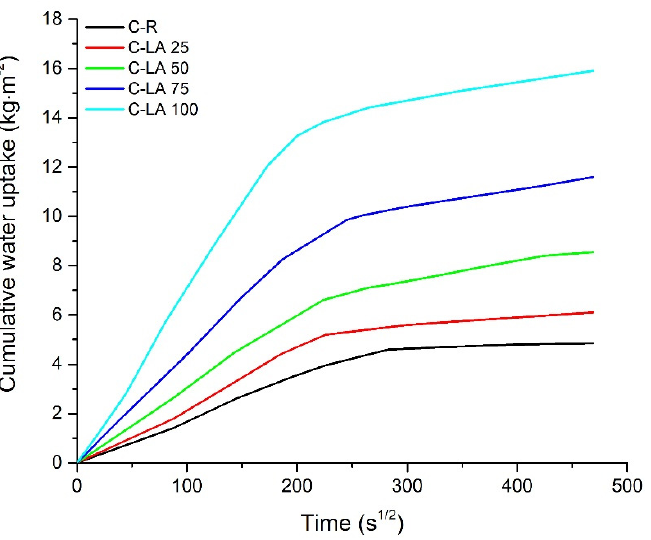
Figure 9. Cumulative water uptake in dependence on the square root of time for R-M and C-LA samples. Table 6. One-dimensional liquid water transport properties.